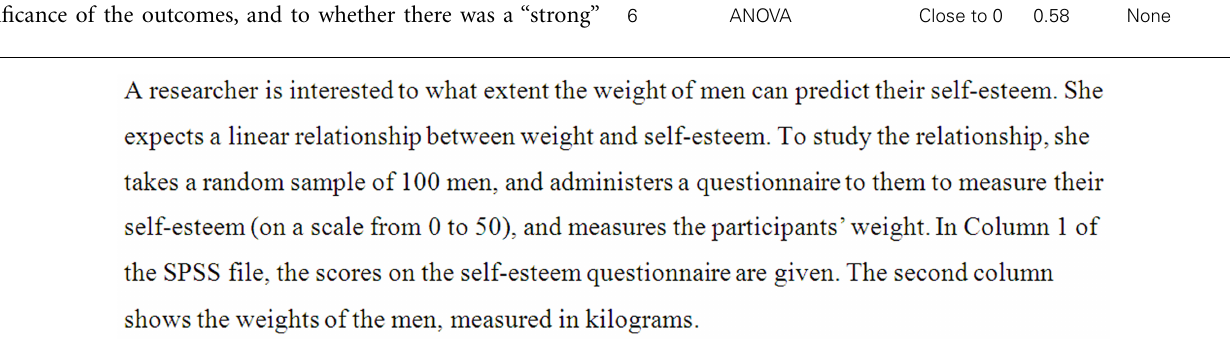
FIGURE 1 |An example of one of the research question descriptions. In this example, participants were supposed to answer this question by means of a regression analysis.